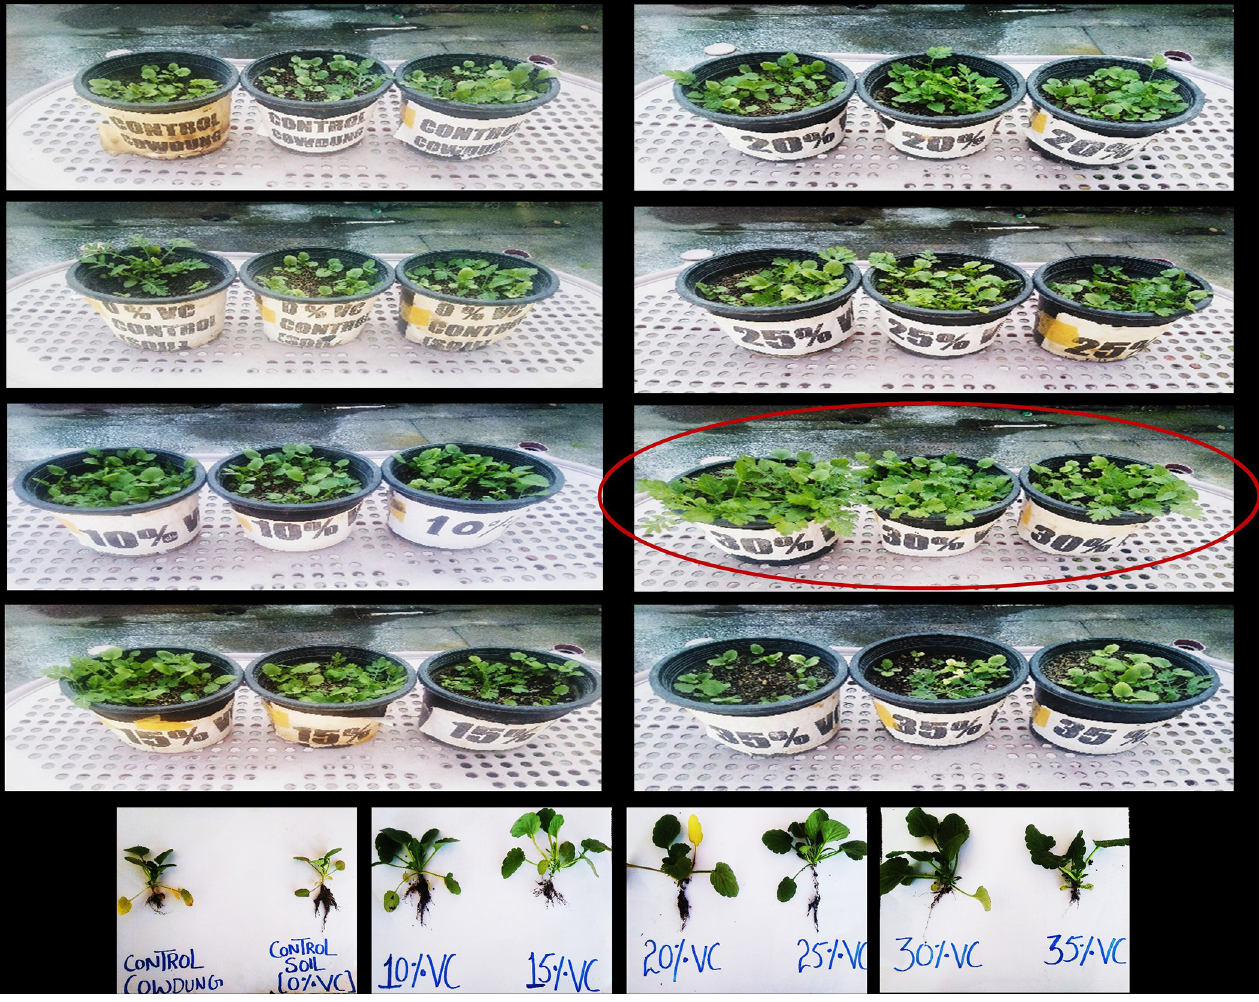
Fig 2. Influence of vermicompost based germinating media on pansy seeding.